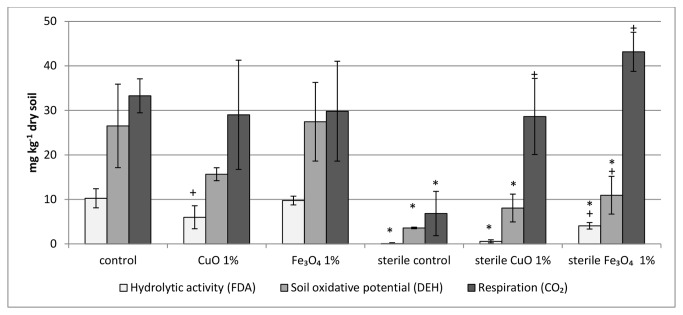
Effect of ENPs on sterilized soil.Soil microbial enzymatic activity measured by three assays FDA, DEH and CO2 on sterile and non-sterile Yatir soil for the assessment of non-biological effects of the two ENP types (for all methods and treatments, n=3). +, treatments that differ significantly from unexposed control (p<0.05) and *, treatments that differ significantly from unsterilized controls (p<0.05).